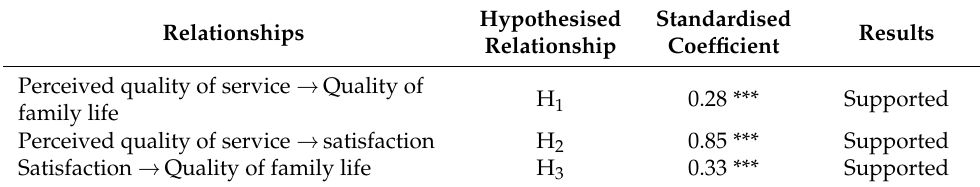
Table 3. Standardised regression weights for the causal paths. Hypothesised Standardised Results Relationships Relationship Coefficient Perceived quality of service → Quality of H 1 0.28 *** Supported family life Perceived quality of service → satisfaction H 2 0.85 *** Supported Satisfaction → Quality of family life H 3 0.33 ***